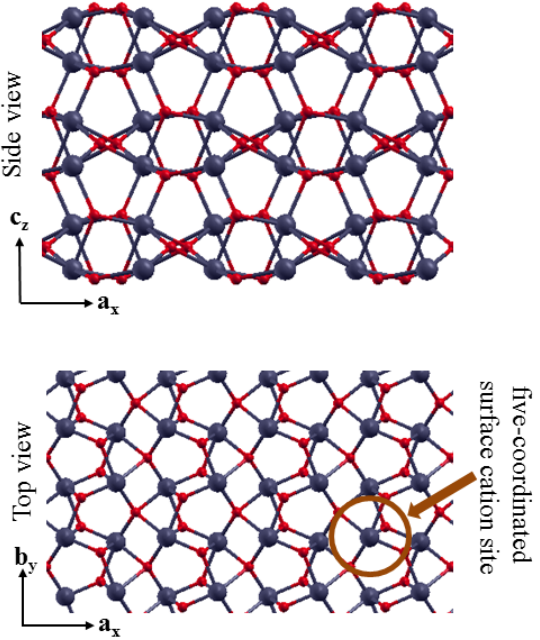
 O {01 1 2} surface. 2 3